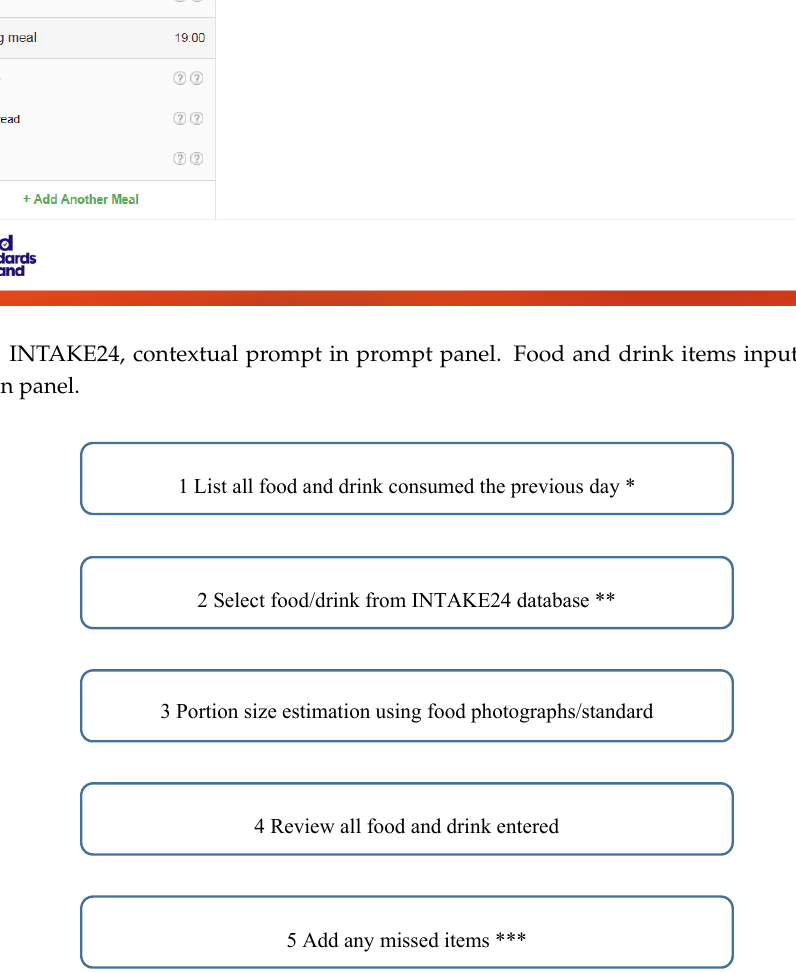
Figure 2. Multiple pass recall method in INTAKE24. * From when user wakes up to when they go to sleep. ** Any missing items are manually entered into the missing food function or the recipe builder.